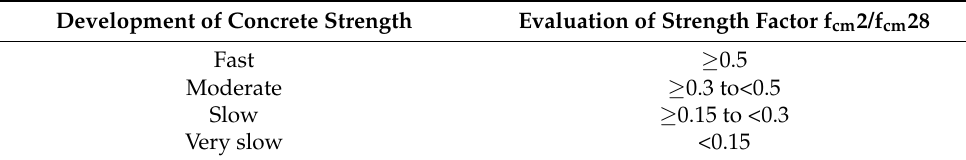
Table 8. Concrete early strength development according to PN-EN 206 [53].